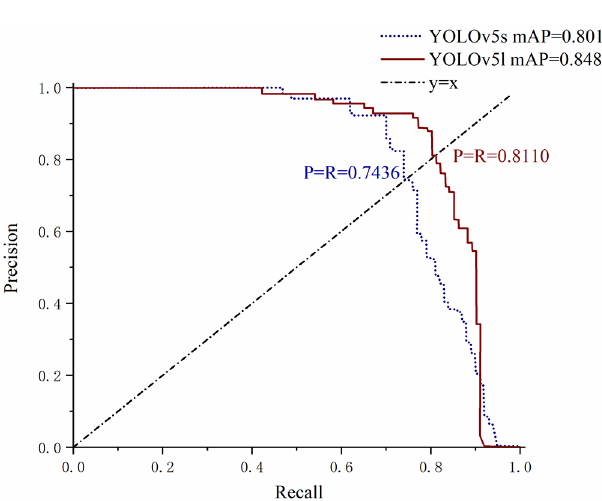
Figure 15. P-R Curve of the measured SAR Image as a test set.